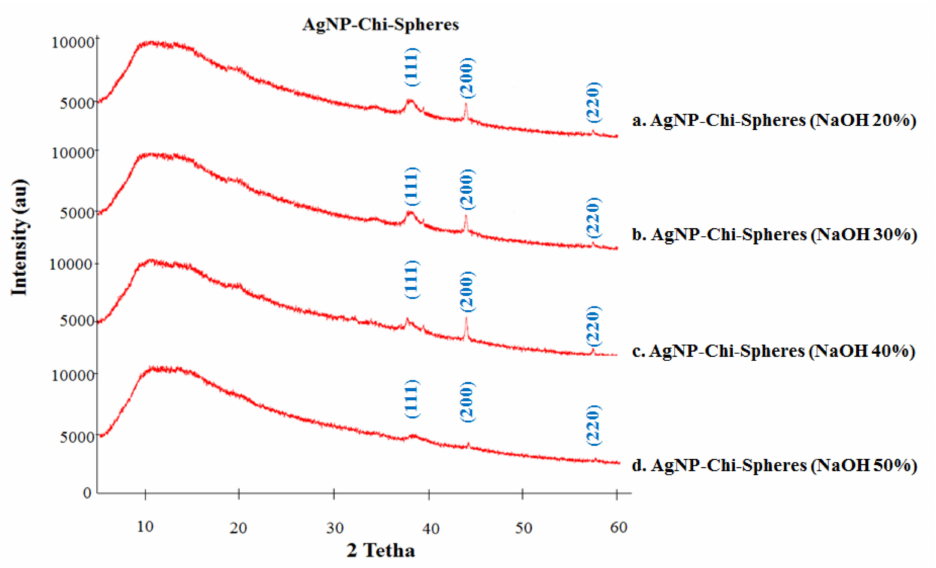
Figure 5. Characterization of AgNP-chi-spheres by